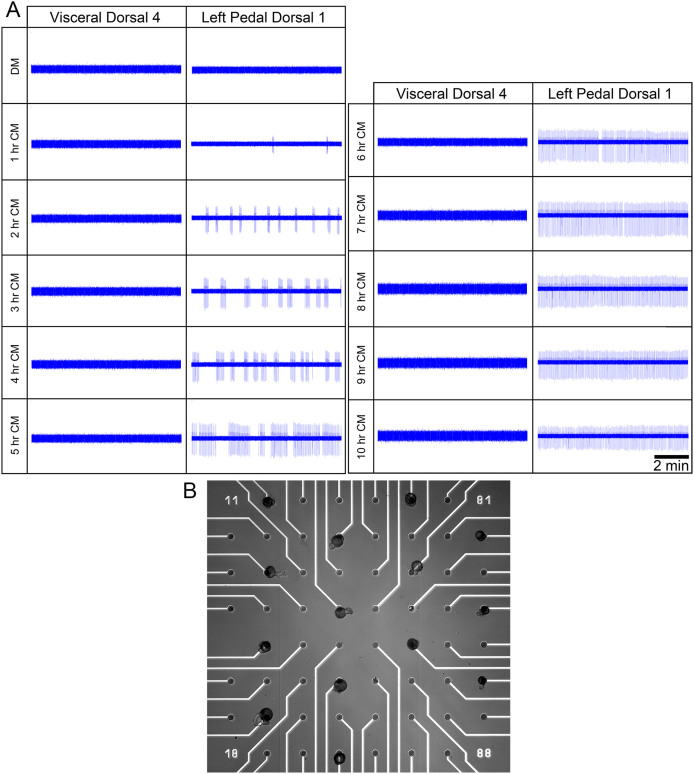
Activity of VD4 and LPeD1 neurons following exposure to CM.Neuronal electrical activity was observed over a 12 hours period using microelectrode arrays. VD4 and LPeD1 neurons were cultured on microelectrode arrays in DM (without trophic factors) overnight and CM (with trophic factors) was added the next day following 2 hours of control DM recordings. (A) A sample 5 minutes trace obtained during DM control and every hour following CM introduction is shown. (B) A representative figure of neuronal placement on the chip. The first three columns on the left are LPeD1 neurons, and the last column on the right shows VD4 neurons.